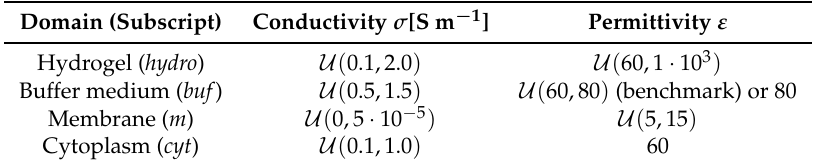
Figure 5. UQ results for the TMP at the cell apex (cell top; red dot) for the benchmark model, where an elliptical cell was assumed to adhere to the bottom of the chamber, representing a 2D cell culture. The mean value is shown together with 90% prediction interval for a broad frequency range (left axis). The first order Sobol indices of the uncertain parameters are shown on the right axis (lines with markers). The parameters, which have Sobol indices less than 0.1 over the entire frequency range, are not shown for the convenience of the reader. These parameters are buffer and cytoplasm conductivity as well as buffer and cytoplasm permittivity. It turns out that the slope of the TMP is mainly defined by the cell membrane conductivity ( σ m ) and membrane permittivity ( ε m ). Table 1. Assumptions for the dielectric properties of electrically conductive hydrogels with an exemplary single cell model [32]. The uniform distribution is denoted by U